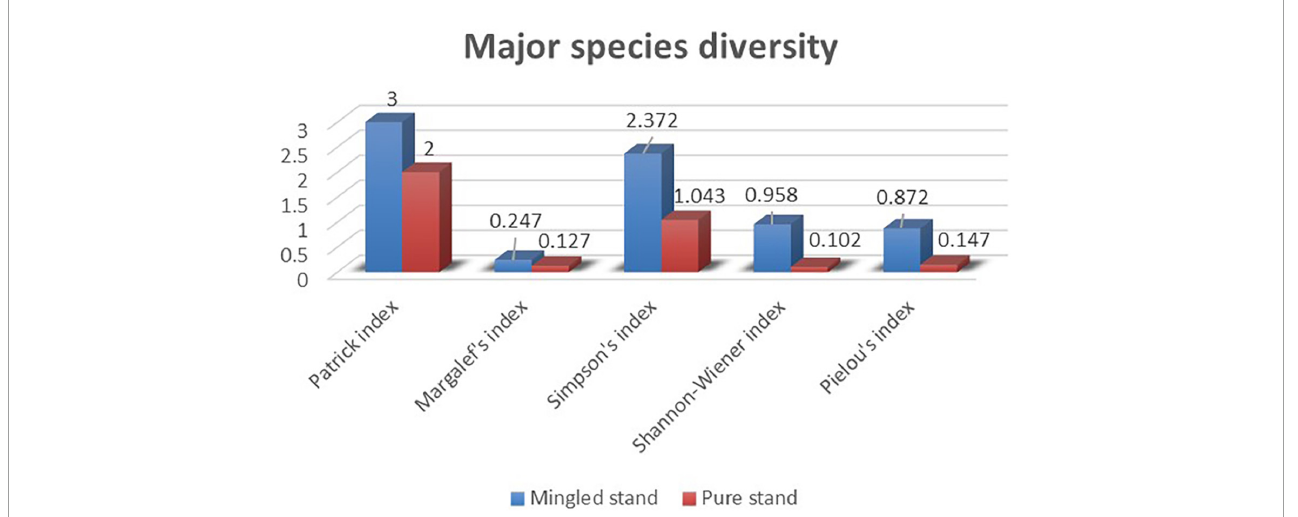
Frontiers in Ecology and